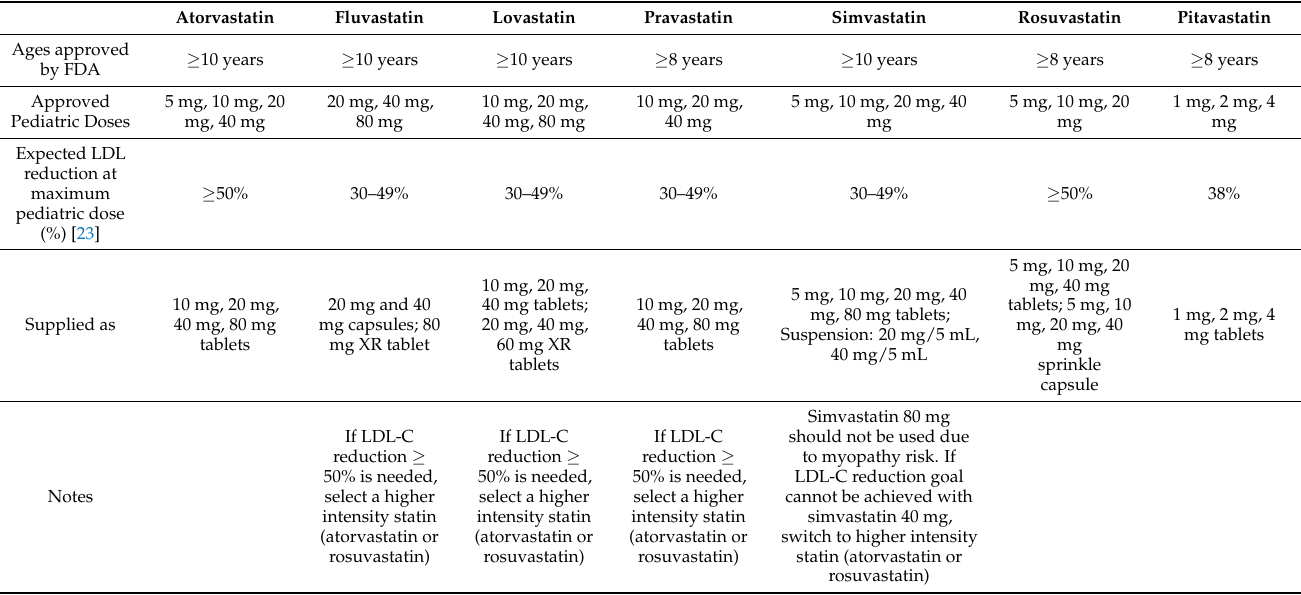
Table 4. Dosing and Expected Effect of Statins Currently Approved for Use in Children and Adoles-